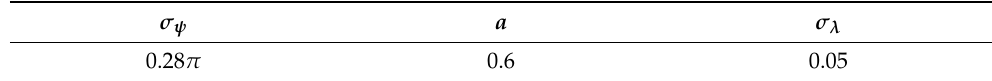
Table 7. Other parameters.